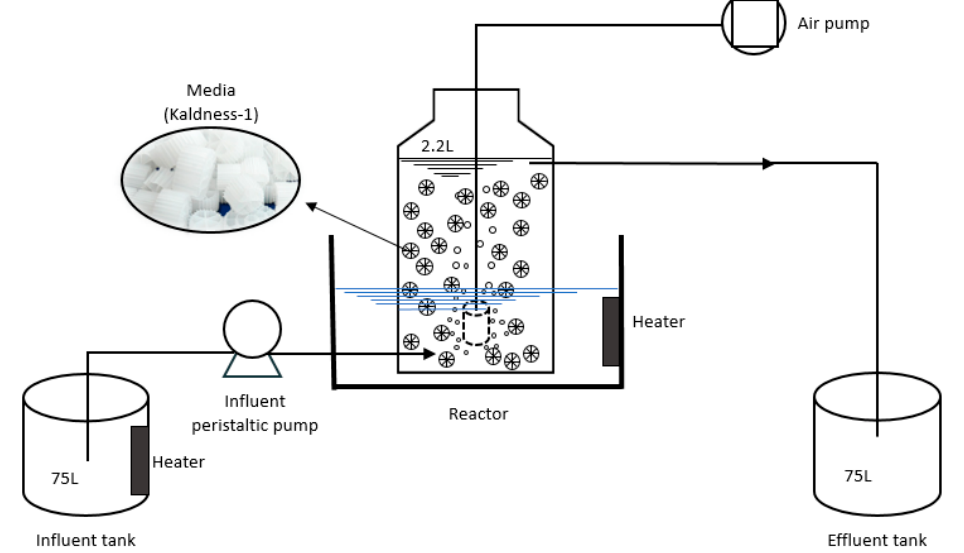
Figure 1. Schematic diagram (not to scale) of the denitrification assembly.